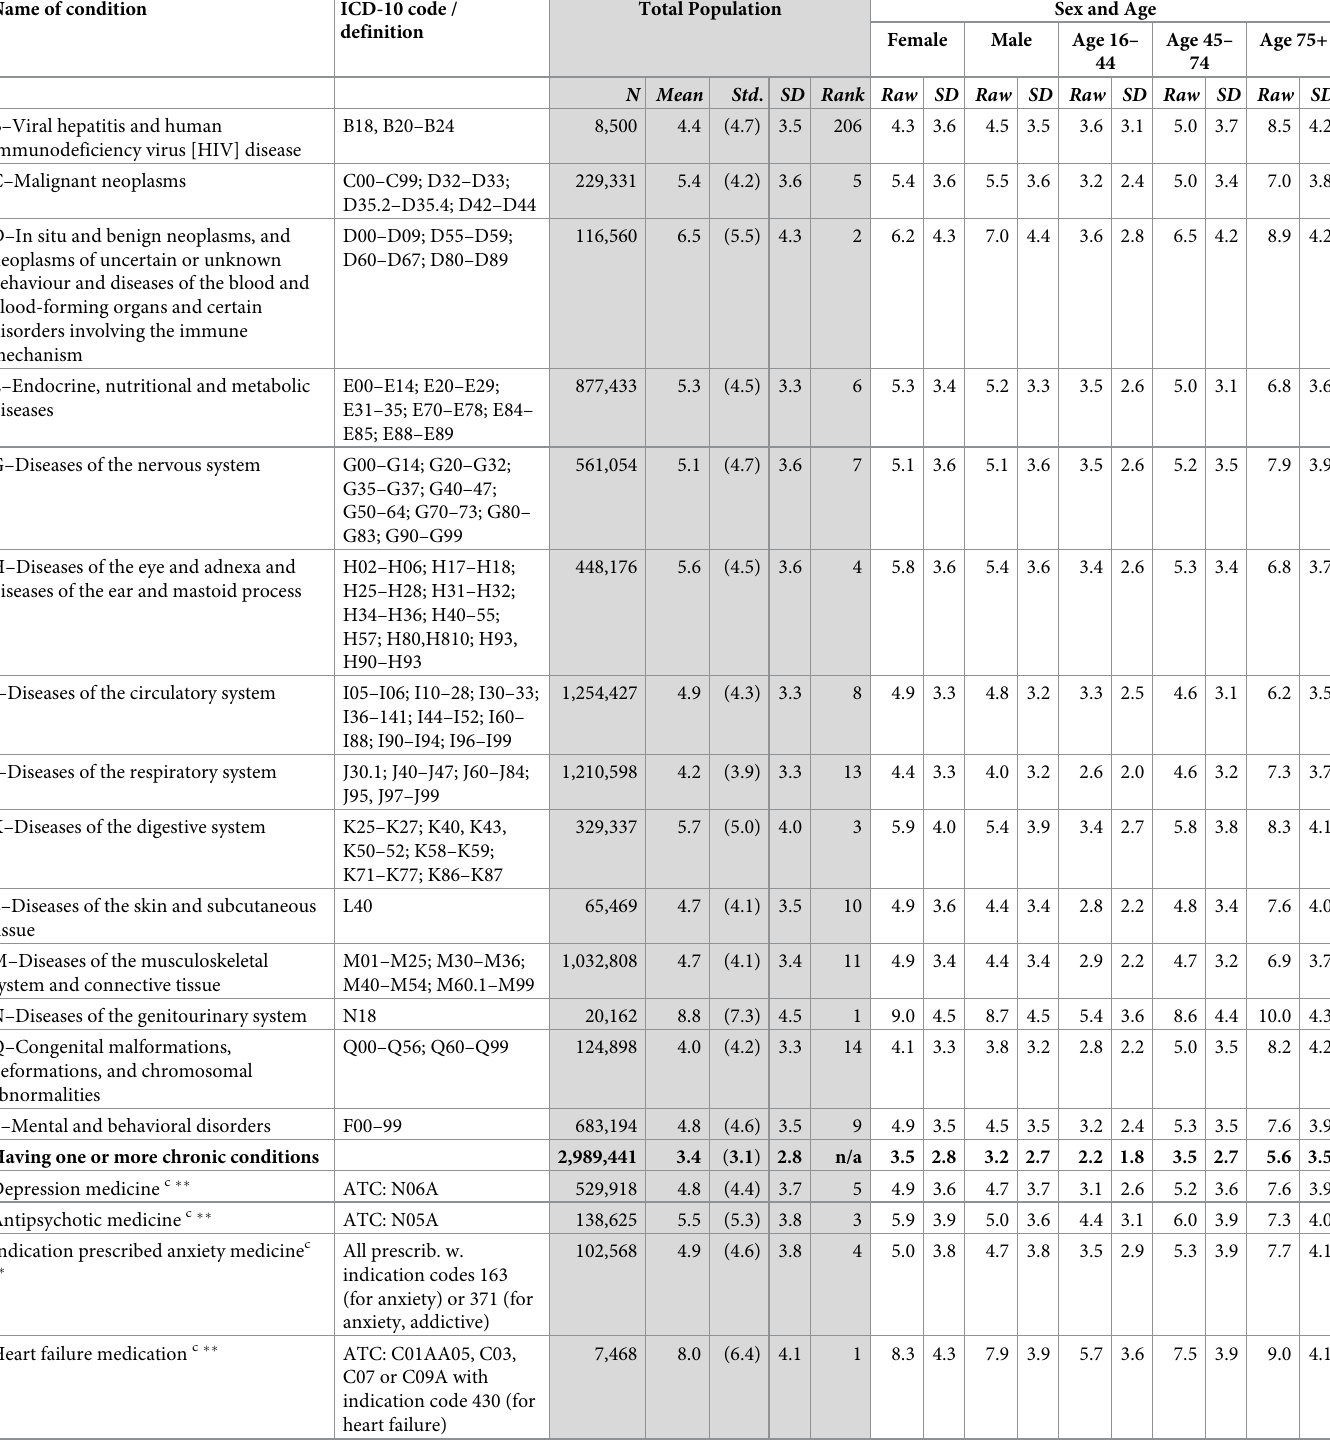
Table 1. Overview of mean NCCs and SD of disease groups and medicines: The number of patients, overall mean NCCs, and by age and sex in Denmark on 1 Janu- ary